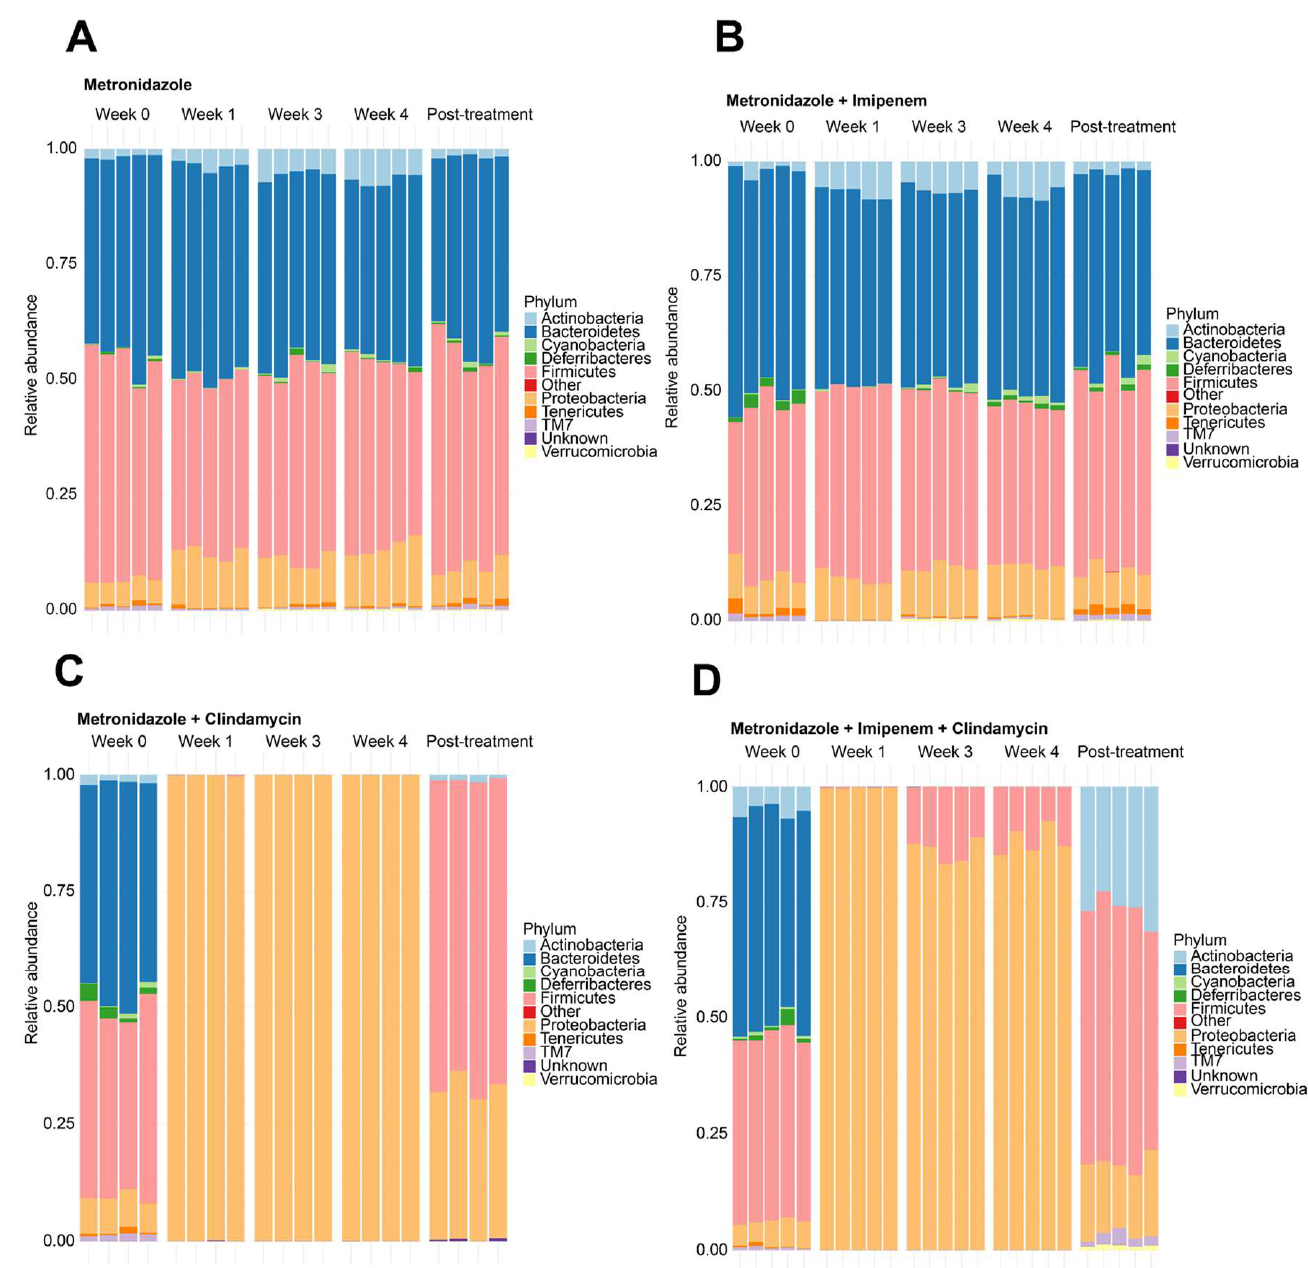
Figure 4. Stacked relative abundance plots at phyla level for mice treated with ( A ) metronidazole, ( B ) metronidazole + imipenem, ( C ) metronidazole + clindamycin, and ( D ) metronidazole + imipenem + clindamycin.